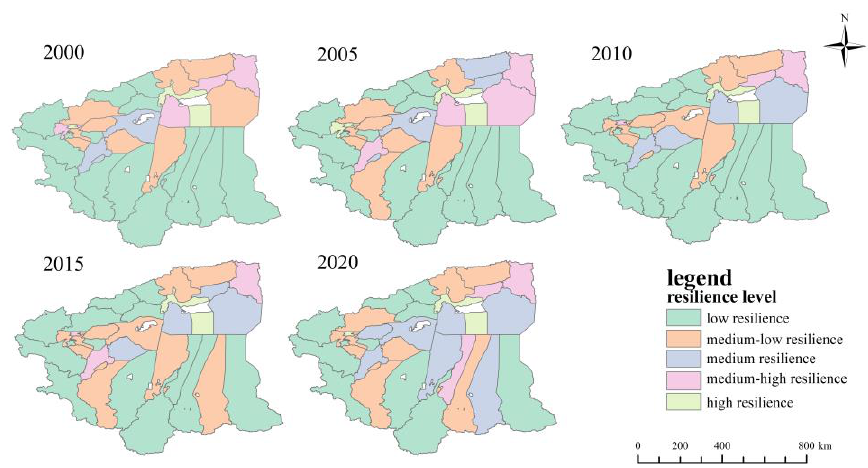
Figure 11. Distribution of comprehensive resilience level of four prefectures in southern Xinjiang from 2000 to 2020.